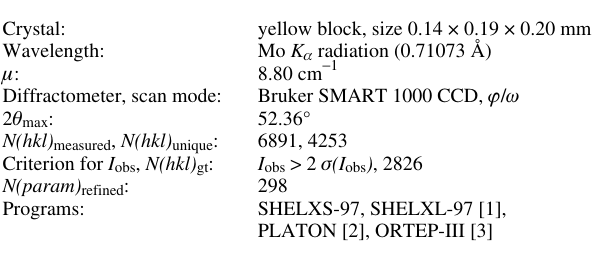
Table 1. Data collection and handling.